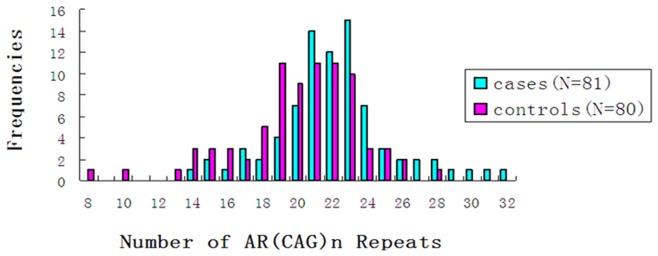
Distribution of CAG repeat length among the MBC patients and control groups.